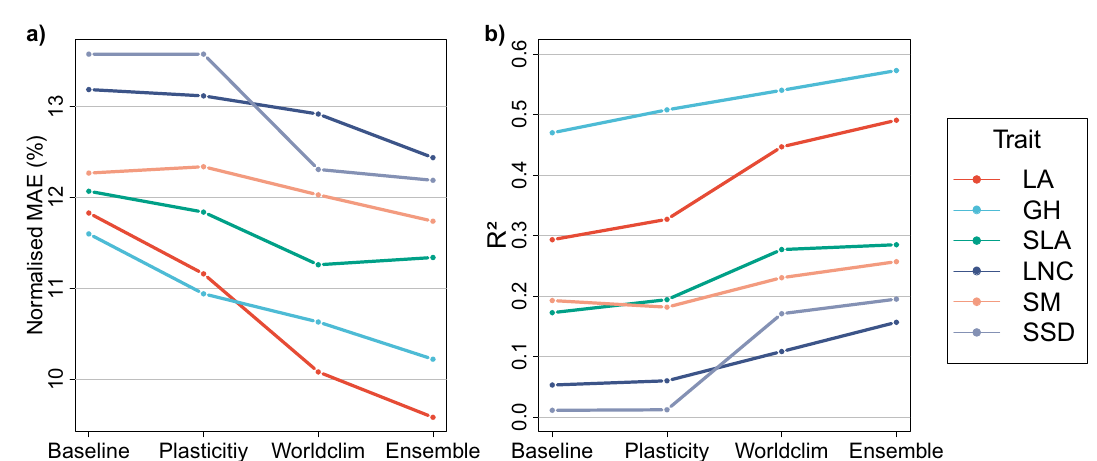
Figure 2. Results of the four model setups. Normalised mean absolute error ( a ) and R 2 ( b ) for the basic CNN model setup (’Baseline’), the setup including trait variability (’Plasticity’), the setup including bioclimatic data (’Worldclim’) and the ensemble setup (’Ensemble’). Mean absolute error was normalised by the respective test dataset’s range to enable a comparison between the predictive performance of the six traits. R 2 shows the explained variance of the linear fit of test predictions versus test targets. 23 . LA, leaf area; GH, growth height; SLA, specific leaf area; LNC, leaf nitrogen concentration; SM, seed mass; SSD, stem specific